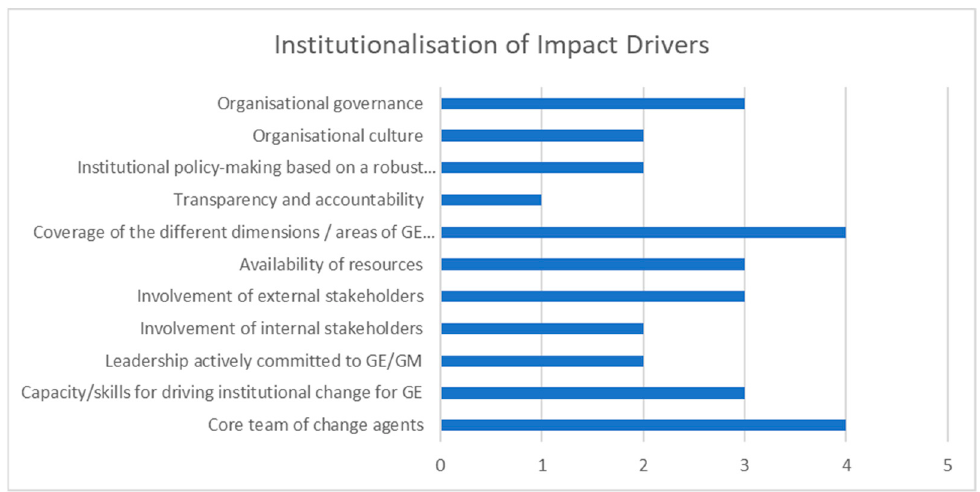
Figure 6. Bar chart with anonymised results of one of the test organisations.